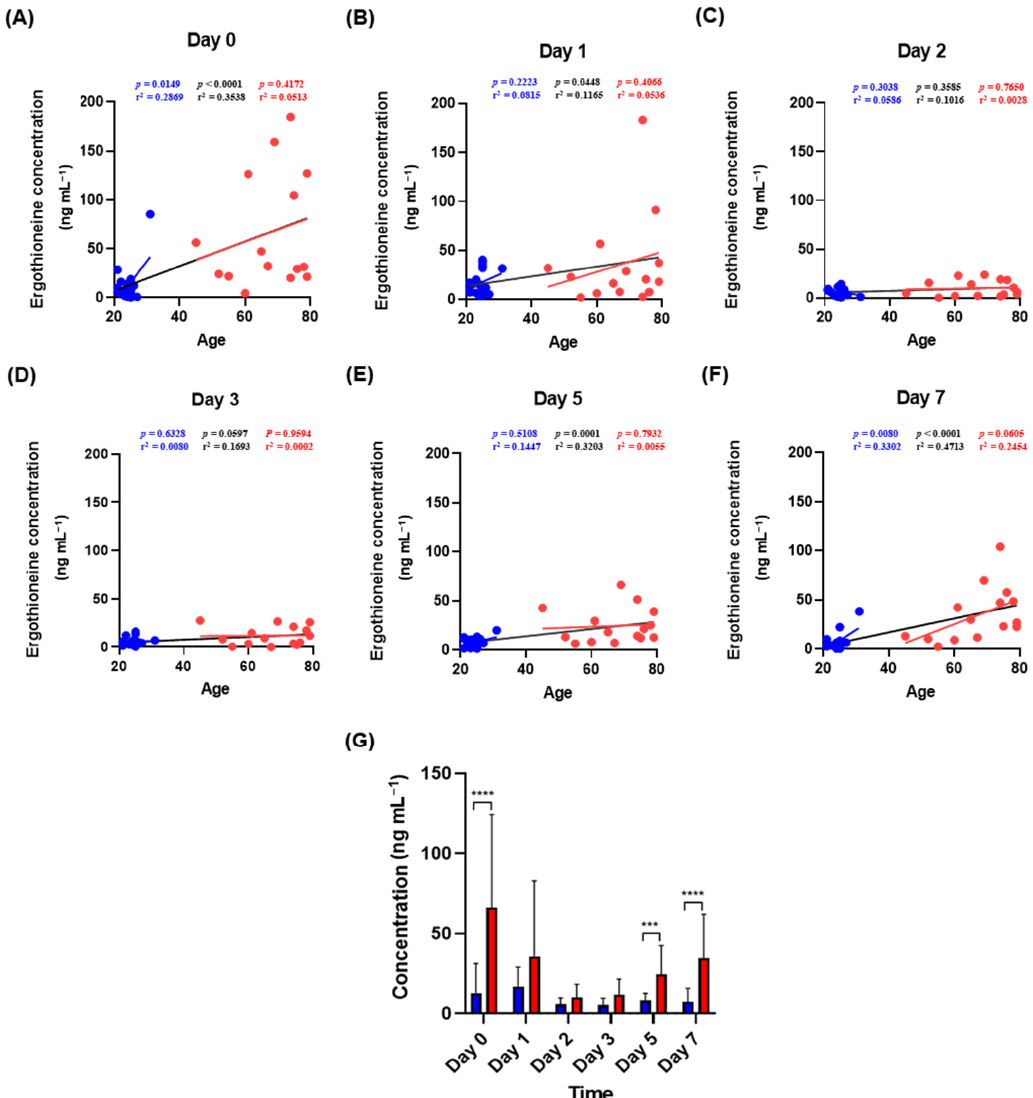
Figure 3. Relationship between donor age and ergothioneine concentration in bloodstains. ( A – F ) Correlation analysis of donor age and ergothioneine concentration at each time point. The p -value, r 2 and trend line of the elderly (red), youth (blue) and the entire group (black) were calculated using Pearson or Spearman correlation analysis. Red dots represent elderly subjects, and blue dots represent youth subjects. ( G ) Age-divided significance within each time point. The youth group is represented by the blue bars and the elderly group is represented by the red bars. The p -values were calculated using unpaired t -tests or Mann–Whitney tests. Values in the graph represent Mean ± SD. *** p < 0.001 and **** p <